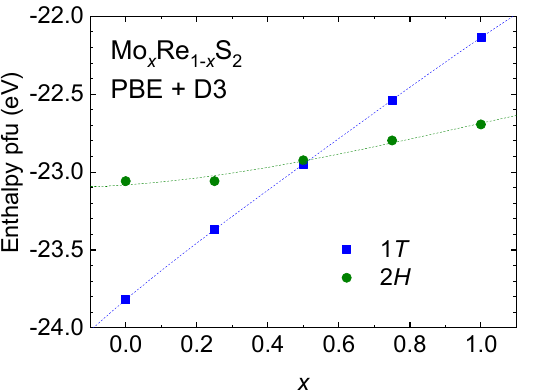
Figure 1. ( a ) Enthalpy per formula unit (pfu) obtained with Perdew–Burke–Ernzerhof (PBE)+D3 density functional theory (DFT) calculations for the 1T- and 2H-MoReS 2 solid solutions as a function of Mo content ( x ). The dotted lines are guides to the eye.